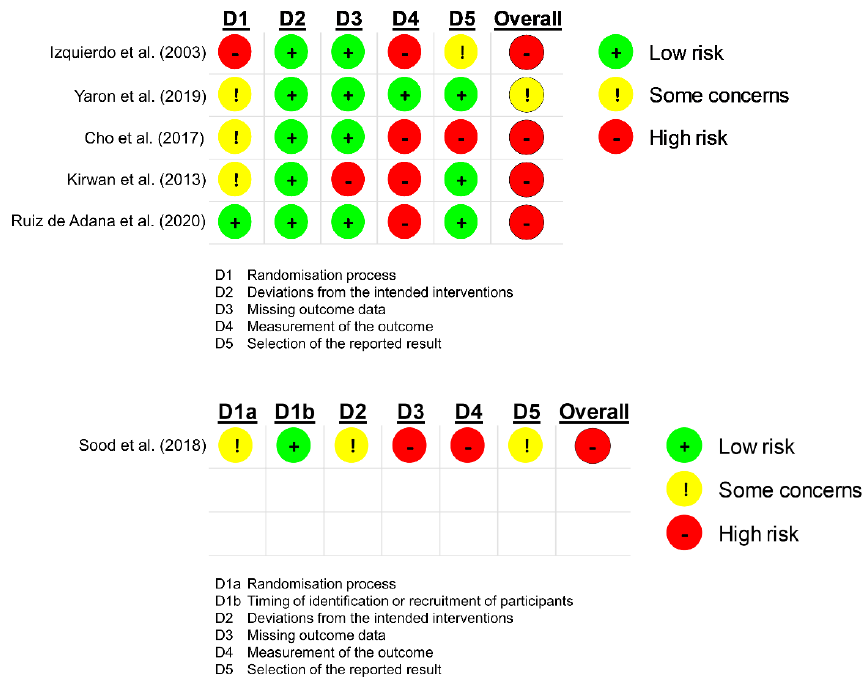
Figure 2. Risk of bias in the included studies. This figure was automatically made by RoB2 tool: https://www.riskofbias.info/welcome/rob-2-0-tool/current-version-of-rob-2 (accessed on 1 Jan- uary